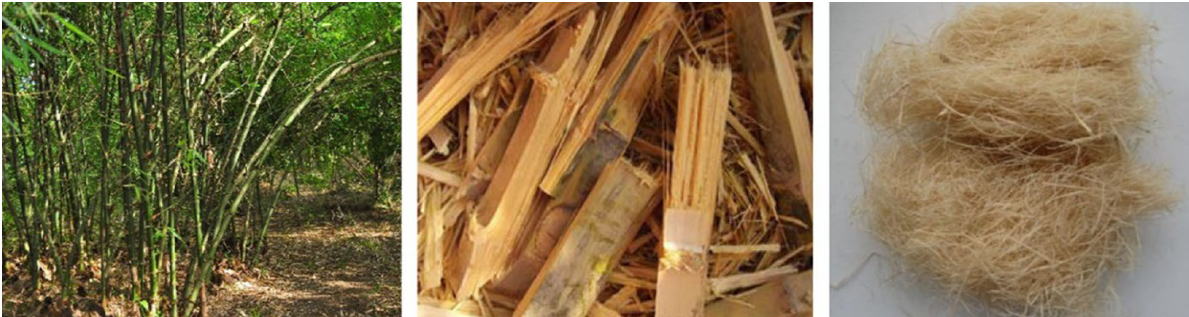
Figure 9: Natural bamboo